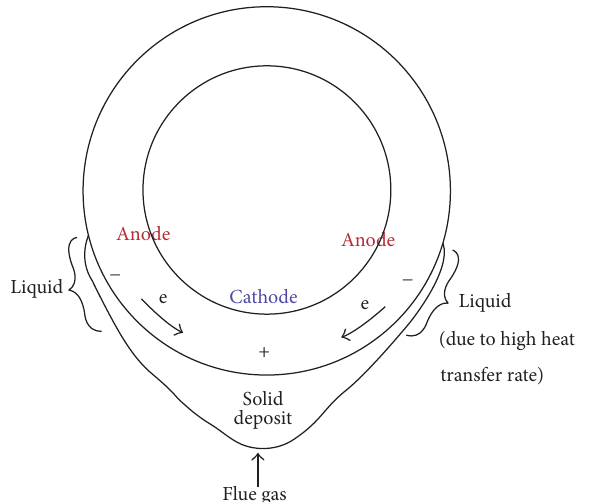
Figure 10: Schematic of corrosion under deposits on the tubes [7].